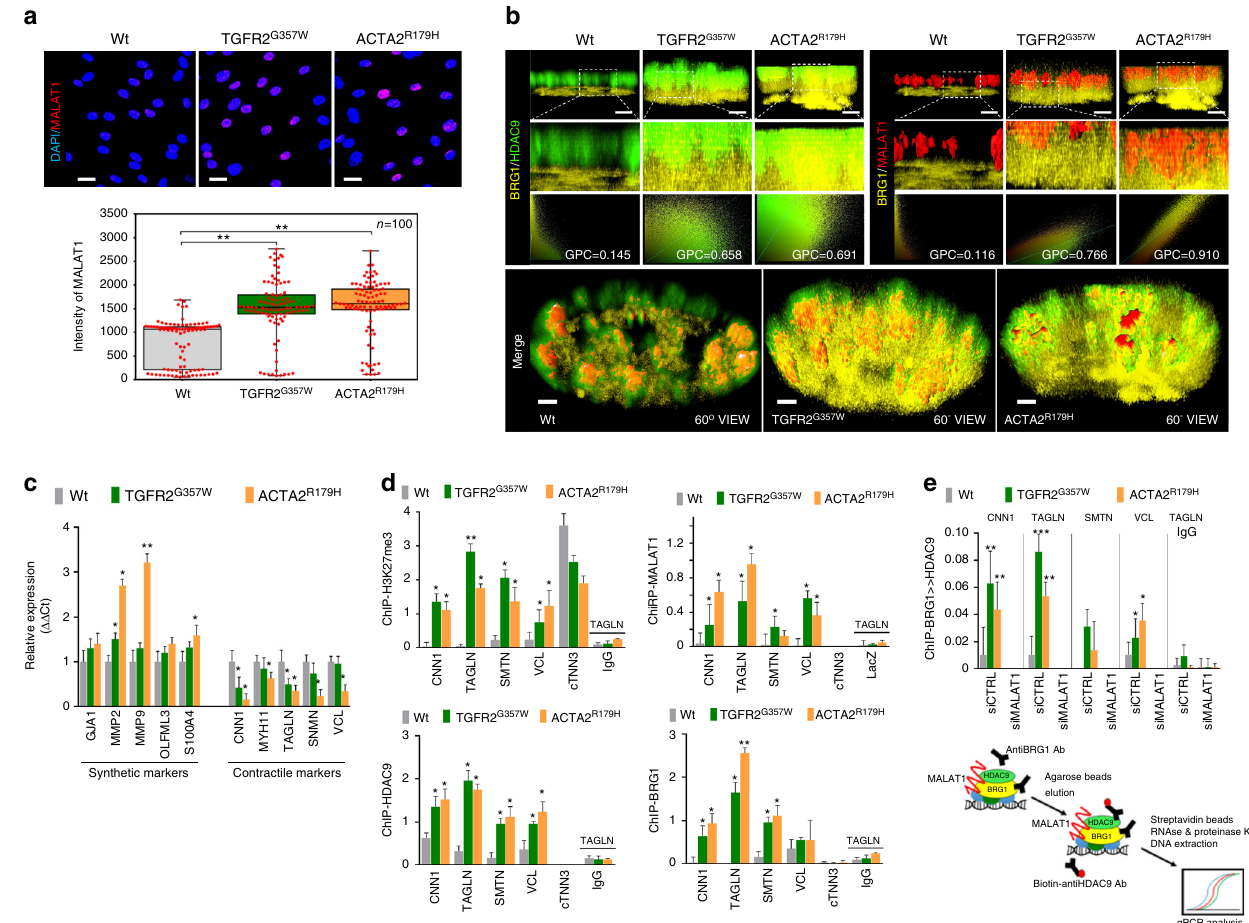
Fig. 4 HDAC9 – MALAT1 – BRG1 complex negatively regulates smooth muscle contractile genes. a Fluorescence in situ hybridization (FISH) demonstrates increased levels of MALAT1 in TGFR2 G357W or ACTA2 R179H expressing cells, (Student ’ s T -test, ** p < 0.01). Bar = 15 µ M b MALAT1, BRG1, and HDAC9 spatially colocalize in TGFR2 G357W -expressing or ACTA2 R179H -expressing cells. 3D ultraresolution microscopy showing the intranuclear colocalization of HDAC9 (green), MALAT1(red), and BRG1(yellow) in TGFR2 G357W or ACTA2 R179H expressing cells. Global Pearson ’ s colocalization (GPC) of spatial overlap between BRG1-HDAC9 and BRG1-MALAT1 in 100 cells per condition is shown. Bar = 2 µ M upper panels, Bar = 1.2 µ M lower panels ( c ) Qualitative PCR analysis of molecular markers of synthetic and contractile SMC phenotypes, primarily demonstrate repression of contractile markers in TGFR2 G357W or ACTA2 R179H expressing VSMCs, (* p < 0.05, ** p < 0.01 vs. WT) Four experimental replicates are quanti fi ed. d ChIP showing increased H3K27me3 marks at the promoters of contractile genes in TGFR2 G357W or ACTA2 R179H expressing cells, (* p < 0.05 vs. WT). Chromatin immunoprecipitation assays (ChIP) showing increased occupancy of HDAC9 and BRG1 proteins and chromatin isolation by RNA puri fi cation (ChiRP) MALAT1 RNA at the promoters of contractile VSMC genes including CNN1 (calponin), TAGLN (Sm22), SMTN (smoothelin), VCL (vinculin), and cTNN3 (troponin) (Student ’ s T -test, * p < 0.05, ** p < 0.01 vs. WT). Four experimental replicates are quanti fi ed. e Serial immunoprecipitation (ReChIP) of BRG1 and HDAC9 demonstrate MALAT1-dependent association of BRG1-HDAC9 immunocomplexes with VSMC contractile promoters. Three replicates are quanti fi ed. Bar graphs are presented as mean with error bars (±S.D.), Student ’ s T -test, * p < 0.05, ** p < 0.01 vs.